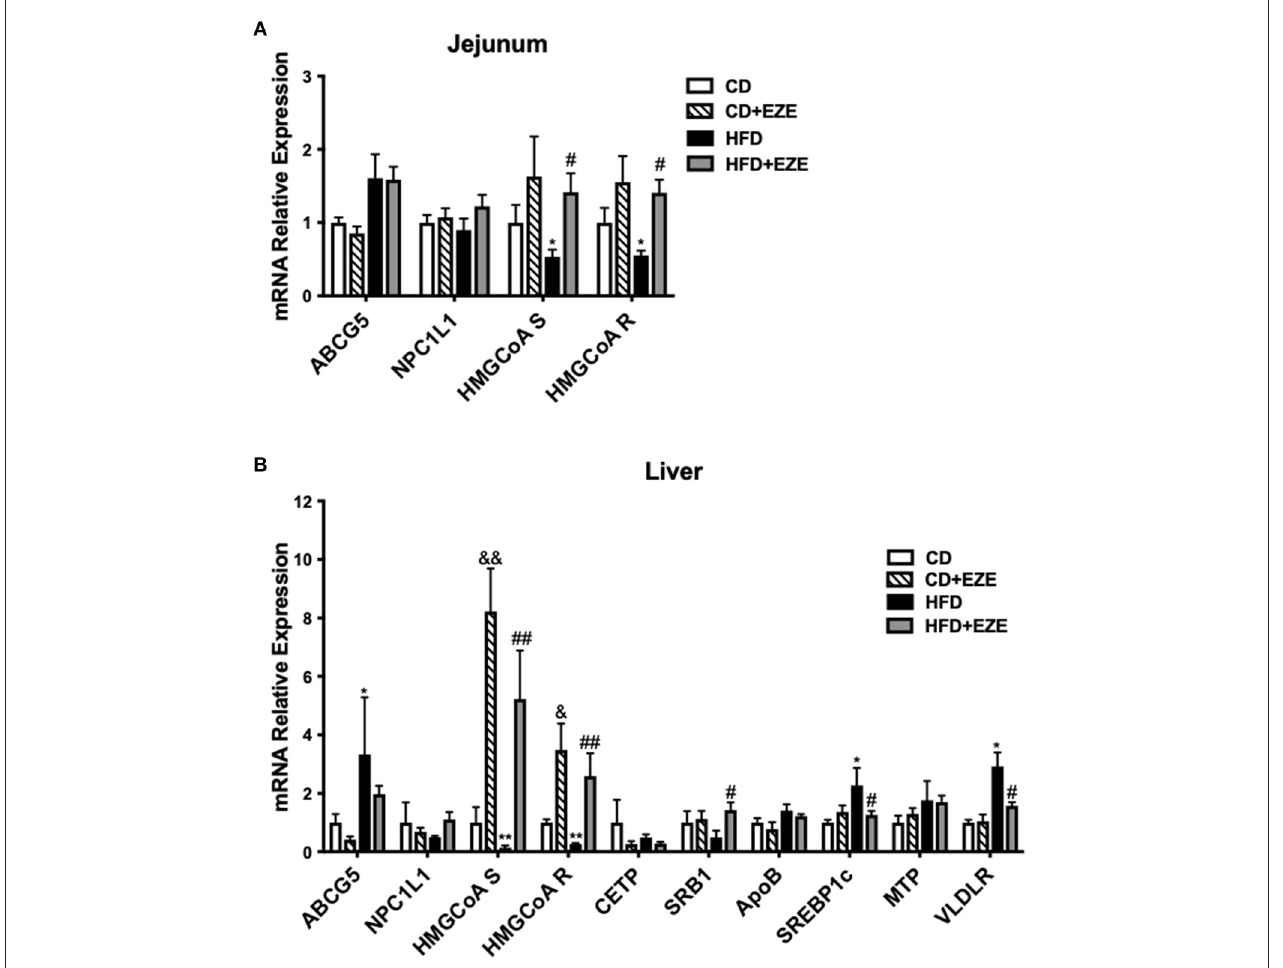
FIGURE 5 | The expression of genes involved in lipid metabolism was determined by real-time PCR. LDLR − / − hamsters were fed CD or HFD for 40 days with ezetimibe ( + EZE) or solvent treatment. Total mRNA was extracted from the jejunum (A) or liver (B) for real-time PCR. Data are shown as expression relative to CD by mean ± SEM, n = 5. Two way ANOVA with Tukey’s multiple comparison test, * HFD vs. CD, * p < 0.05, ** p < 0.001; & CD + EZE vs. CD, & p < 0.05, && p < 0.001; # HFD + EZE vs. HFD, # p < 0.05, ## p < 0.001.